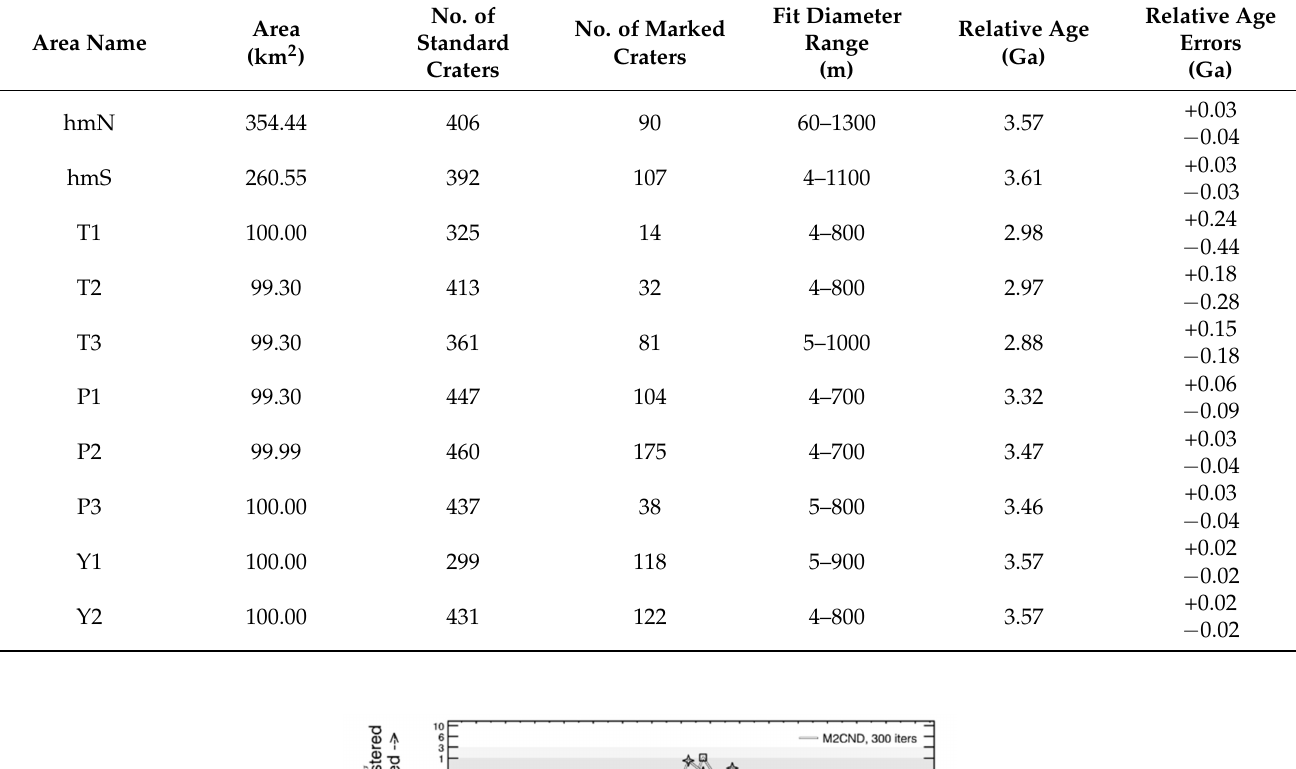
Table 1. The first column repeats the names of the areas considered for the crater size–frequency distribution (CSFD) measurements. The area locations are visible in Figure 2a. The second, third, and fourth columns contain the surface extent of each area, the number of craters selected as standard and as marked (e.g., irregular craters, possible secondary craters, or possible clusters of craters). The fifth, sixth, and seventh columns contain the diameter range of the selected craters and the relative age with correlated errors as from Craterstats2 [37].